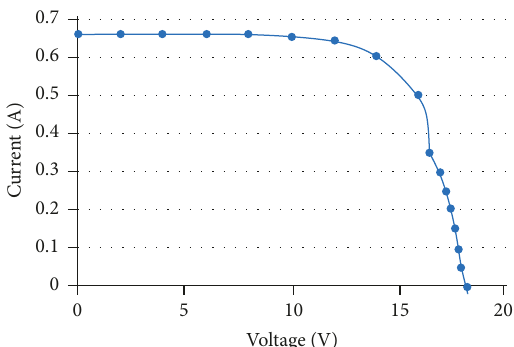
Figure 5: V-I characteristics of polycrystalline lunar panels.